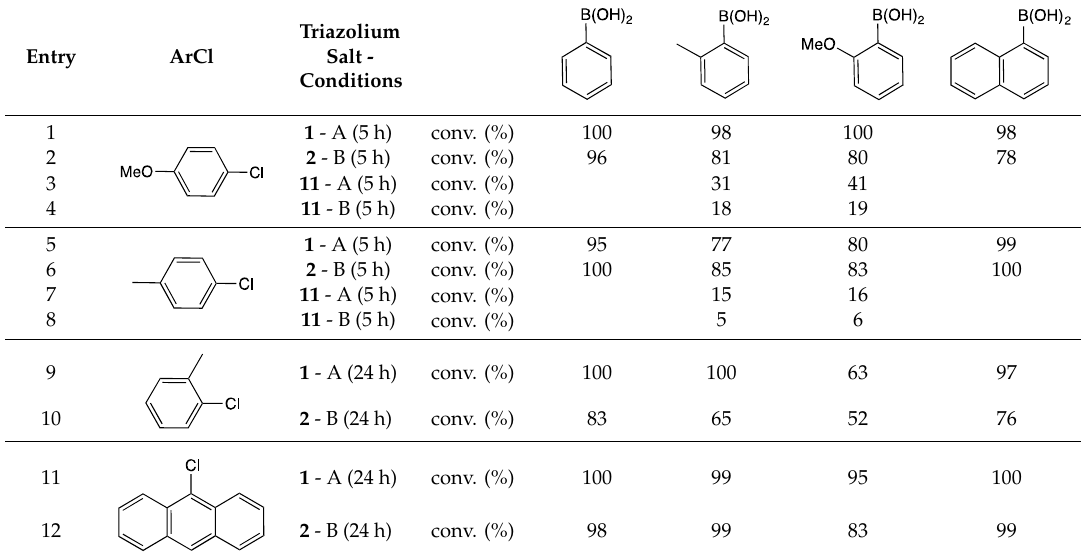
Table 2. Suzuki–Miyaura cross-coupling of aryl chlorides using triazolium salts 1 or 2 .